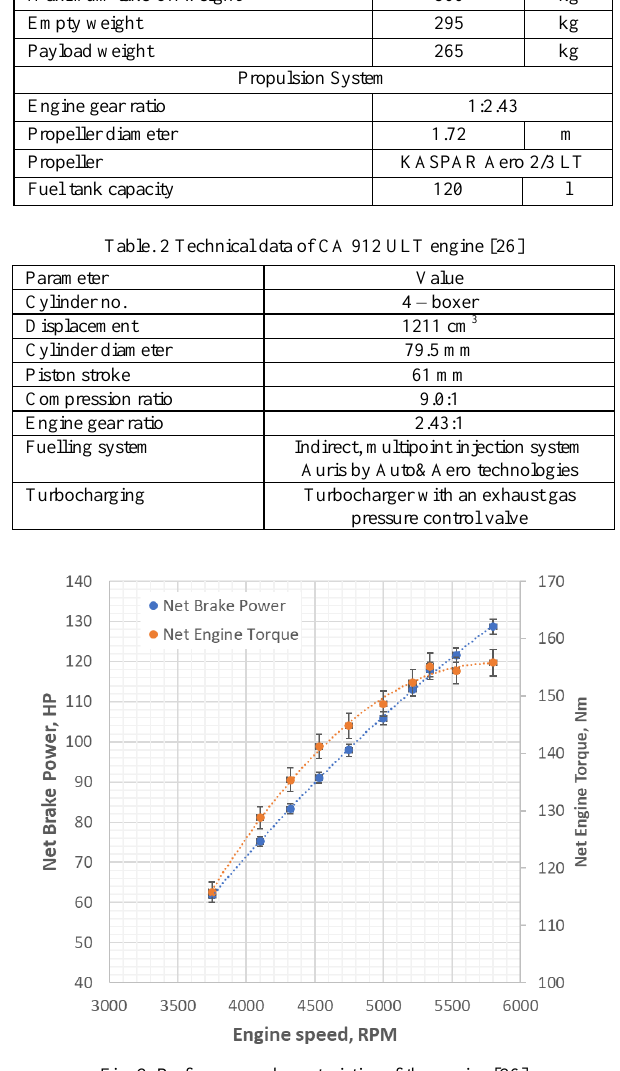
Fig. 2. Performance characteristics of the engine